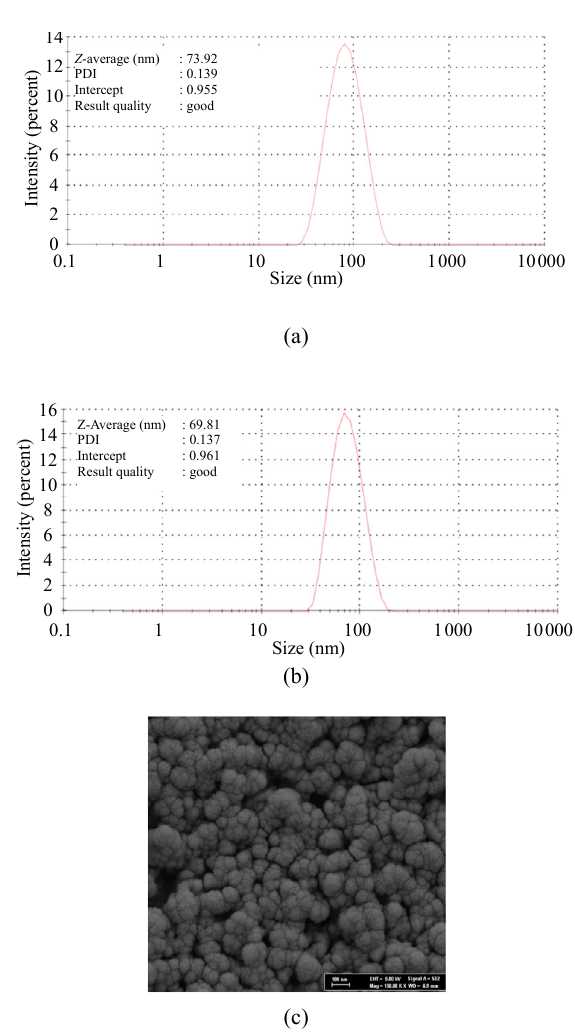
Fig. 3 Zeta sizer: (a) MIP and (b) NIP nanoparticles; SEM images: (c) MIP